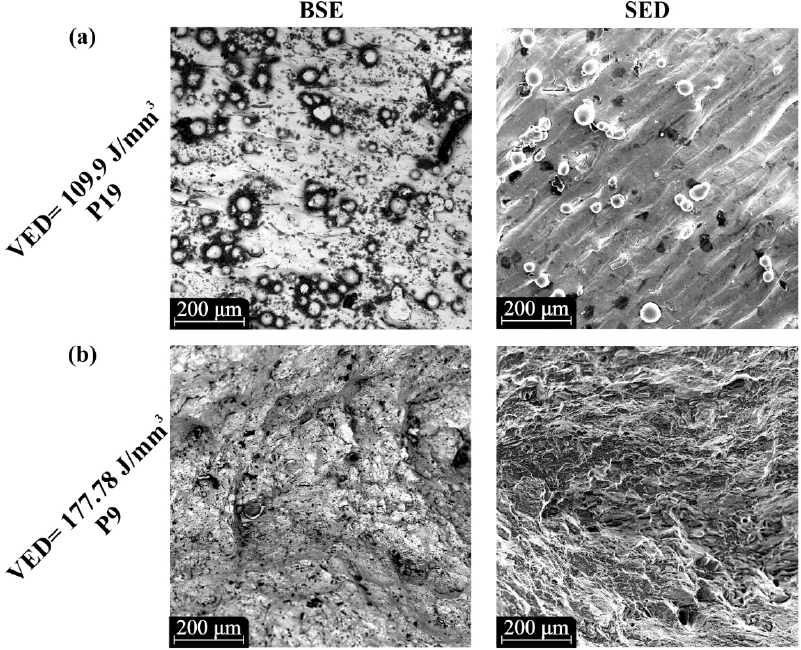
Figure 6. SEM images for the front surface of the specimens: ( a ) 3D printing strategy with low energy 3 ); ( b ) 3D printing strategy with high energy density (>160 J/mm 3 density (<110 J/mm 3 ); ( b ) 3D printing strategy with high energy density (>160 J/mm 3 ). density (<110 J/mm